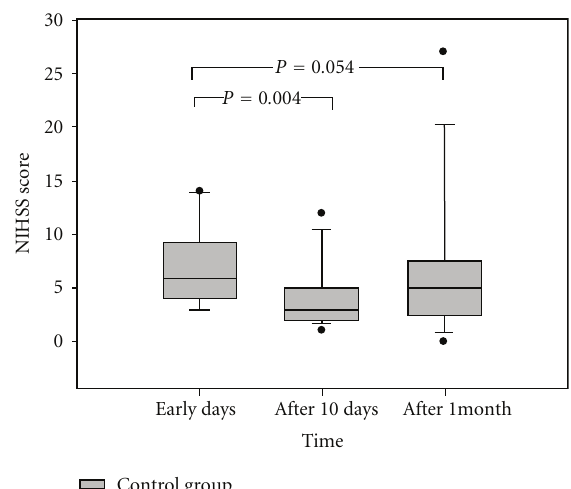
Figure 3: The clinical outcome (NIHSS score) in the control group. The NIHSS scores were significantly decreased on the 10th day after stroke ( P < 0 . 05) but without any di ff erence after one month ( P = 0 . 054).